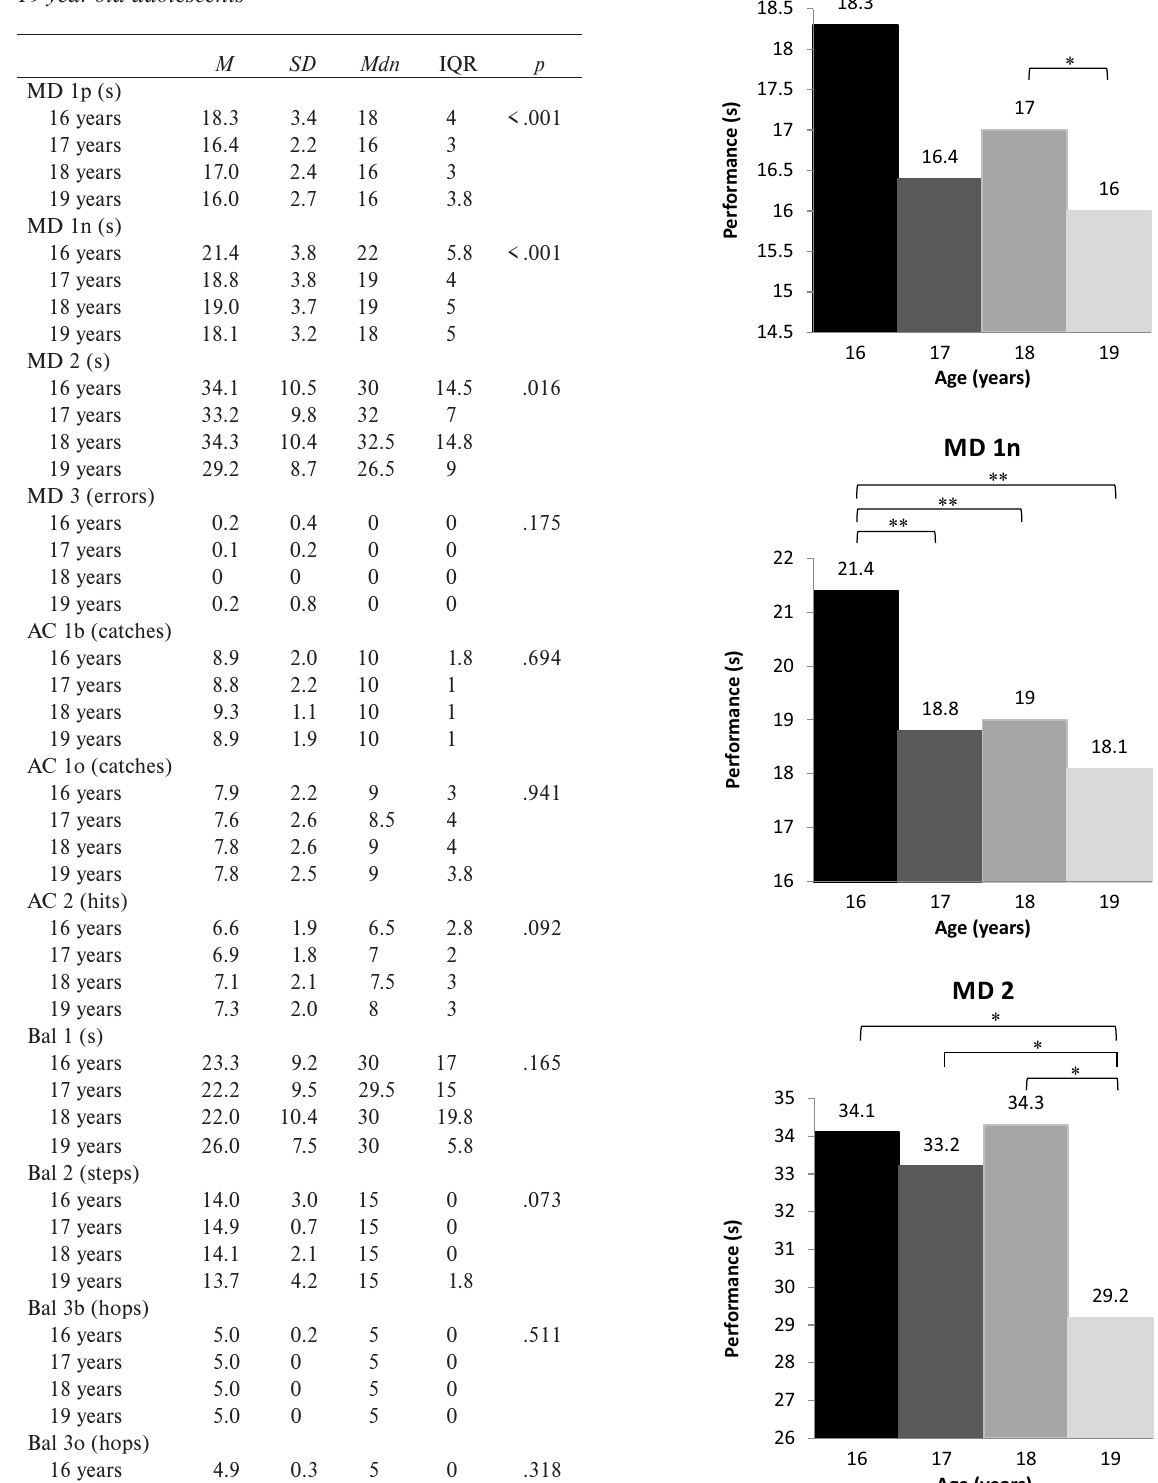
Descriptive characteristics of the performance in the test tasks of the MABC-2 test – age band 3 in 16-, 17-, 18-, and